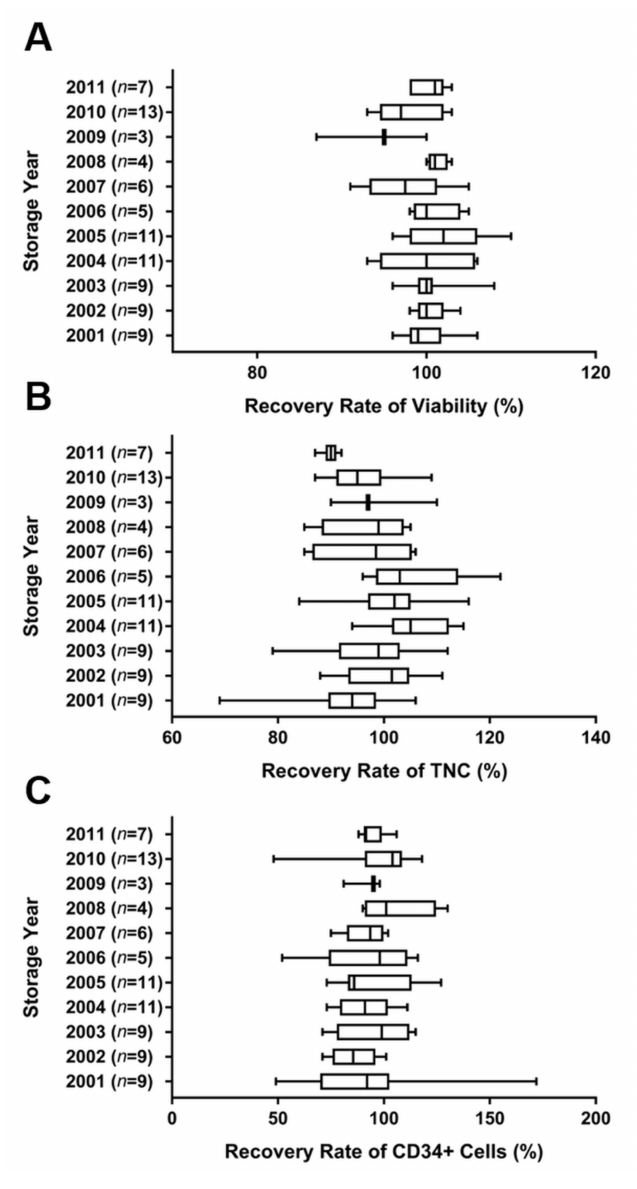
Figure 1. Recovery rates of viability ( A ), TNCs ( B ), and total CD34+ cells ( C ) from 87 cryopreserved human CB units stored from 2001 to 2011. The viability and the cell types were analyzed before and after cryopreservation. The average recovery rates of viability, TNC count, and total CD34+ cell count in total cryopreserved CB were 99.8 ± 4.0%, 98.2 ± 8.7%, and 93.8 ± 18.0%, respectively. Values of p > 0.99 ( A ), p > 0.06 ( B ), and p > 0.99 ( C ) indicated no significant difference between samples with different cryopreservation periods. Data are presented as mean ± standard deviation of